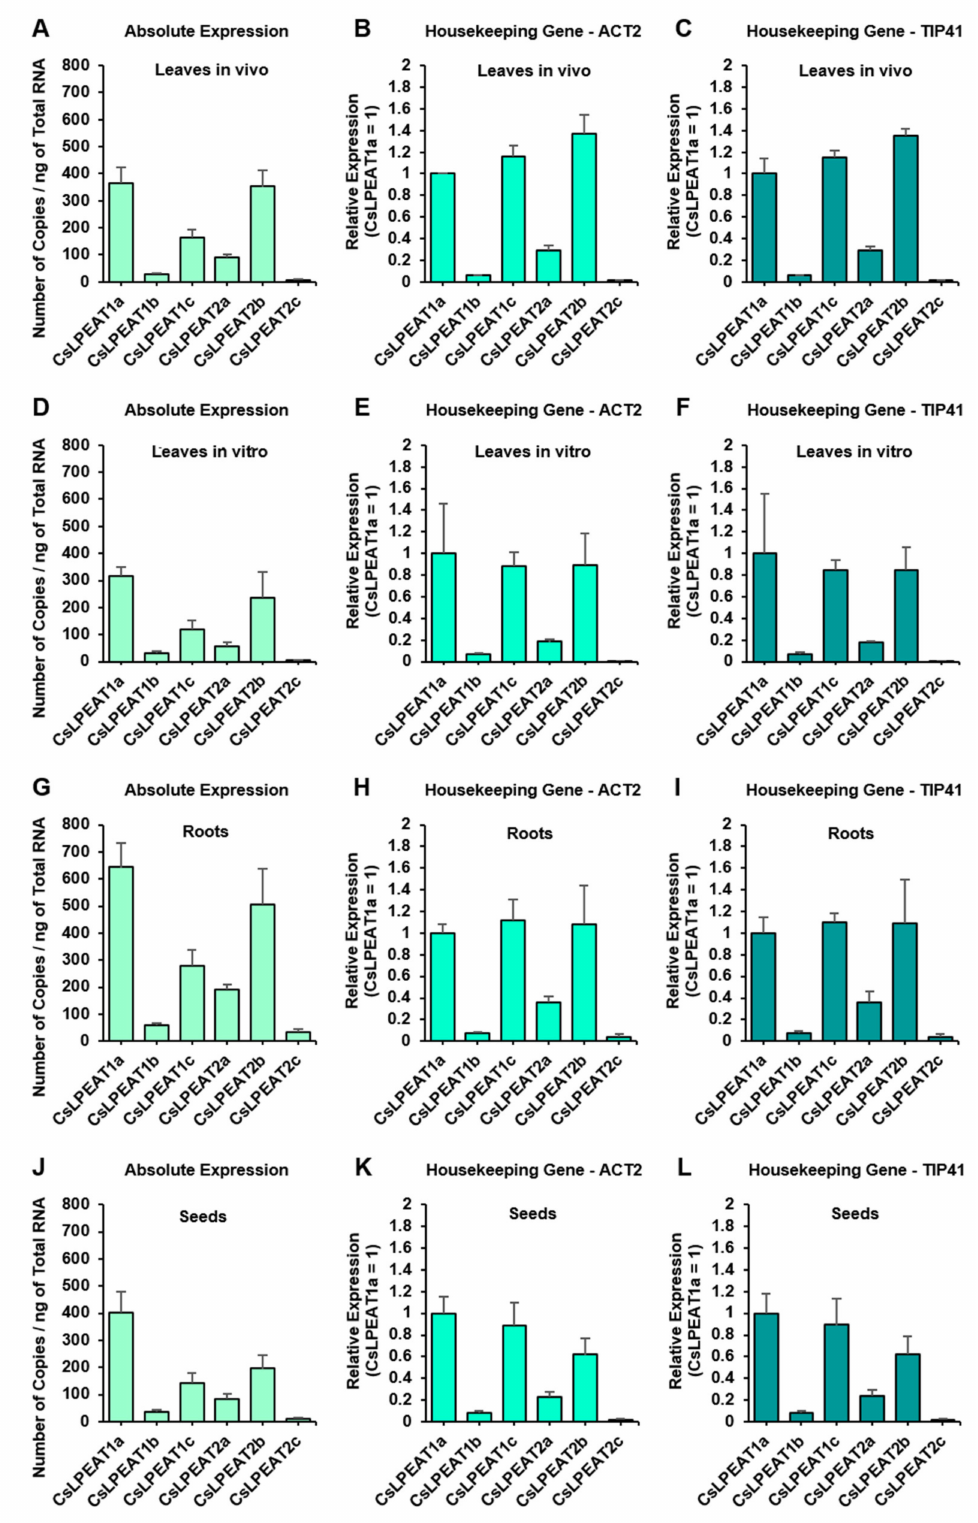
Figure 5. Analysis of differences in Cs LPEAT1 and Cs LPEAT2 isoform expression between different plant tissues: in vivo leaves ( A – C ), in vitro leaves ( D – F ), in vitro roots ( G – I ) and seeds ( J – L ). Panels ( A , D , G , J ) represent absolute quantification expression measurements, while other panels represent relative expression in comparison to Cs ACT2 ( B , E , H , K ) and Cs TIP41 ( C , F , I , L ). Error bars indicate standard deviations (SD) between biological replicates ( n =